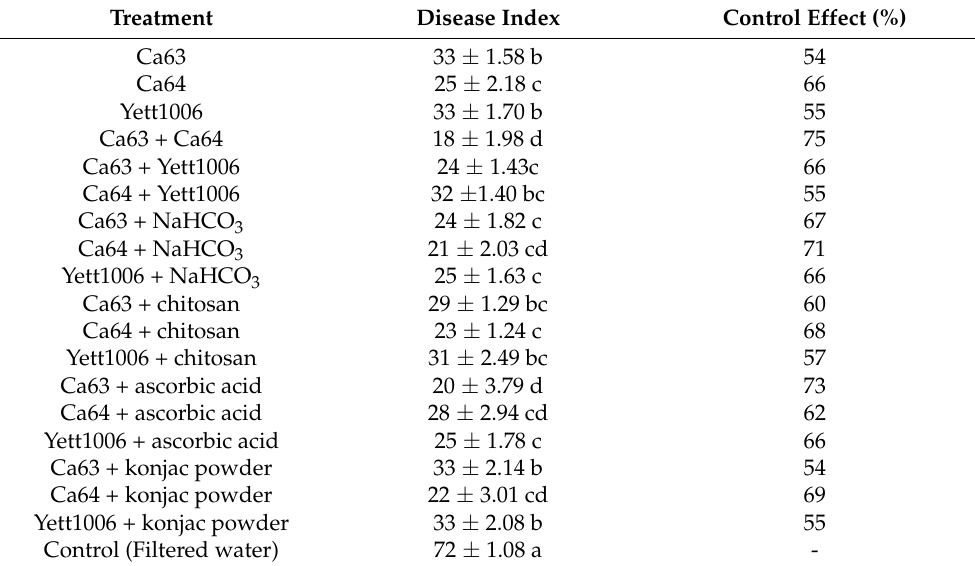
Table 6. Biocontrol effect of three strains and their different combinations on snap beans inoculated with Botrytis cinerea